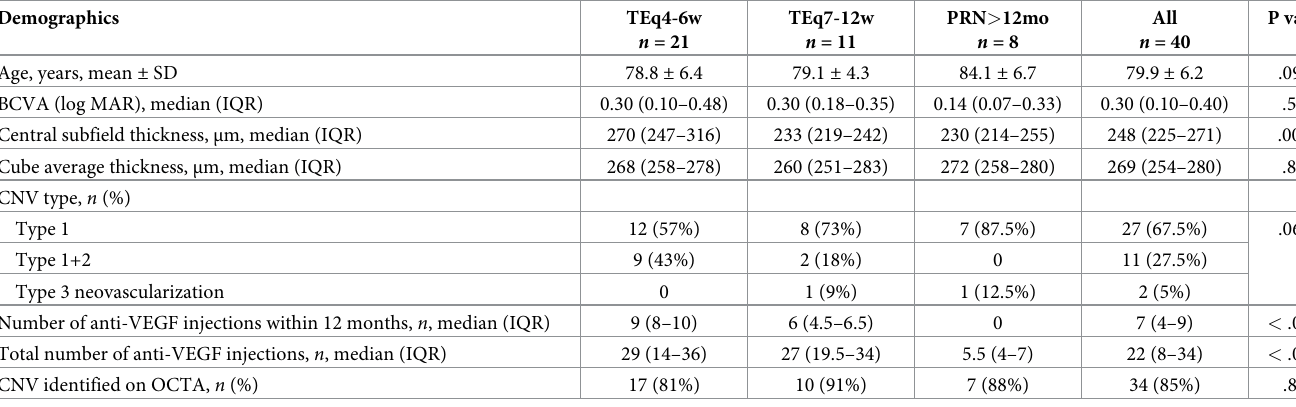
Table 1. Patients